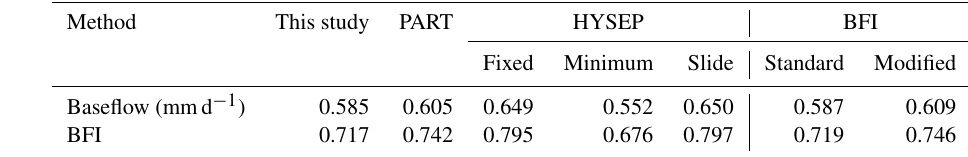
Table 2. Average baseflow and baseflow index (BFI) estimated for 2002–2016.